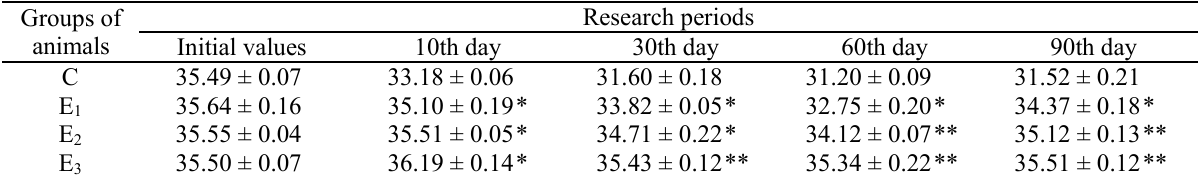
The activity of glutathione peroxidase in the serum of piglets in chronic nitrate-nitrite toxicosis, nmoles/min for 1 mg of protein (М ± m, n = 5) Groups of